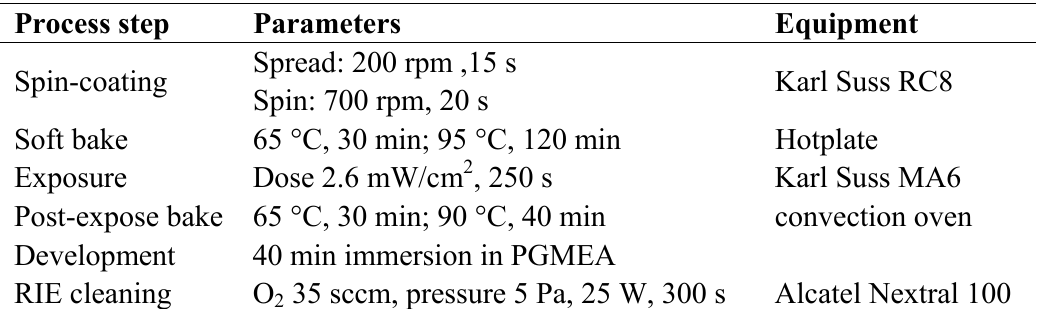
Table 2. Process conditions of SU-8 2100 (from MicroChem) with mold height of about 500 μ